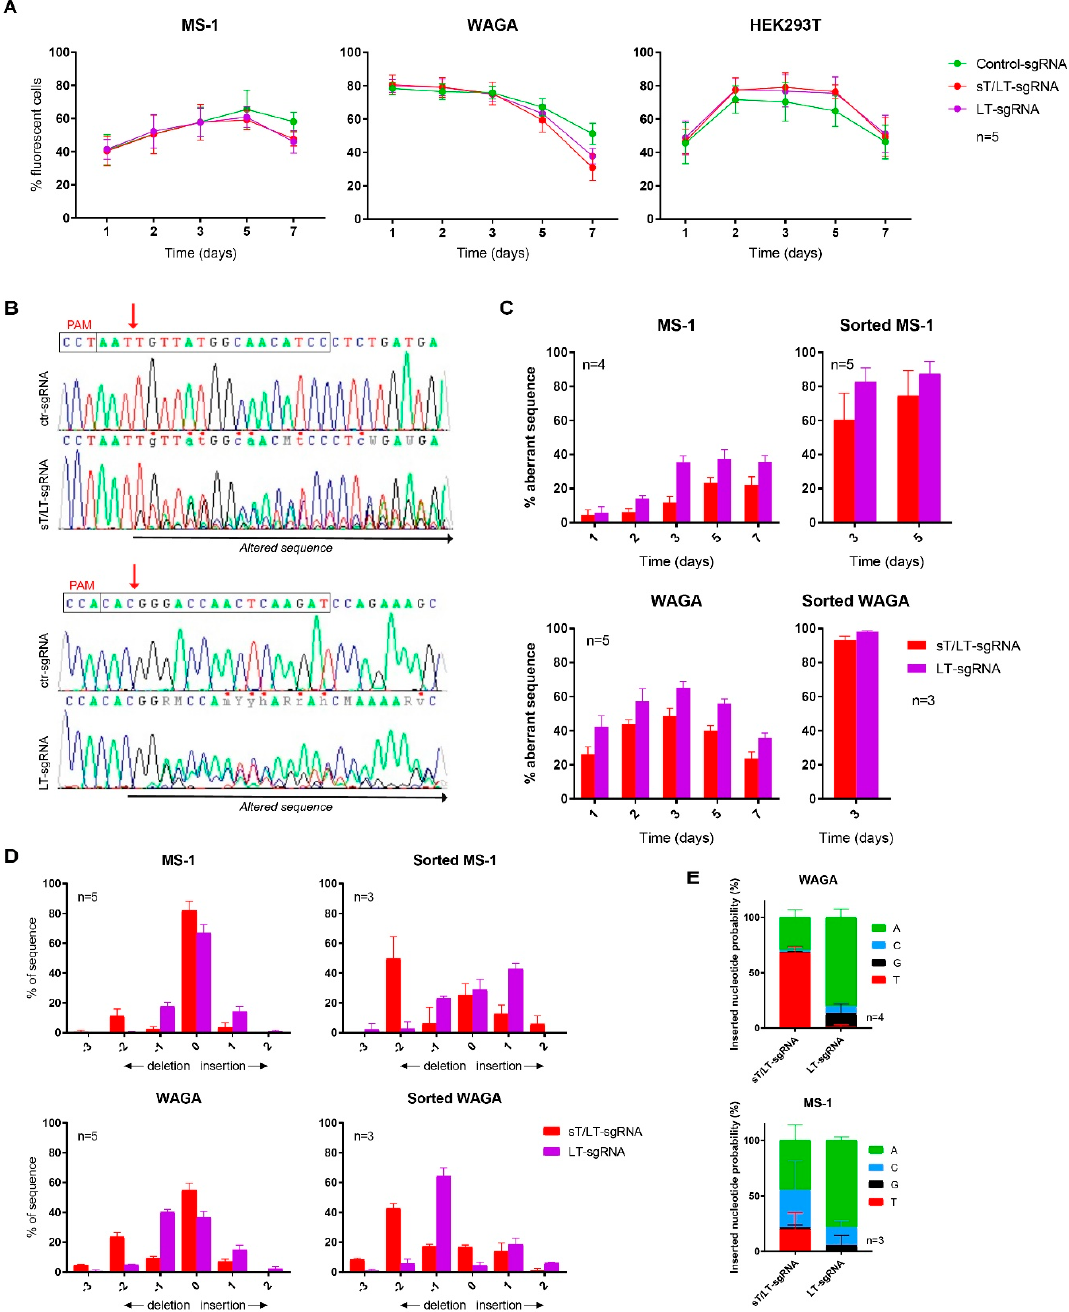
Figure 2. CRISPR / Cas9 editing induced mutations in MCPyV TAs genomic sequence. ( A ) Evolution of OFP fluorescence during the seven days post-transfection; ( B ) Representative electropherograms of MCPyV TAs genomic sequences after CRISPR / Cas9 editing with the indicated sgRNAs. Boxes delimit the PAM sequence and the sgRNAs target sites. The red arrows denote the Cas9 cleavage position while the black left-right arrow indicates the mutated sequence; ( C ) Results of Tracking of Indels by DEcomposition (TIDE) analysis in sequences from cells expressing Cas9 and the specified sgRNAs. Sequences from cells expressing the ctr-sgRNA were used as reference control; ( D ) Indels distribution in genomic sequences from CRISPR / Cas9-targeted cells; ( E ) Probabilities (%) of insertion of each nucleotide in cells expressing each one of the sgRNAs. Data represent mean values ± SD and the number of independent experiments is indicated